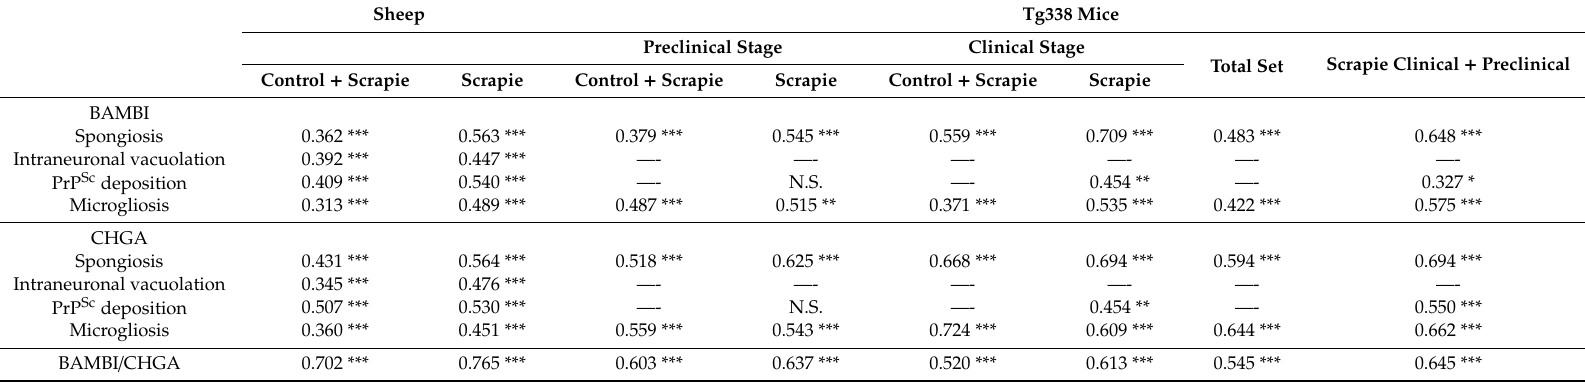
Table 1. Spearman correlation values between BAMBI and CHGA immunostaining scores and scrapie-related histopathological lesions (spongiosis, intraneuronal vacuolation, PrP Sc deposition and microgliosis) in sheep (in the total set of sheep and only in scrapie-infected sheep) and Tg338 mice (in the preclinical and clinical stage, in the total set of animals and only in scrapie-inoculated mice). Correlations were estimated using the full set of data obtained in all